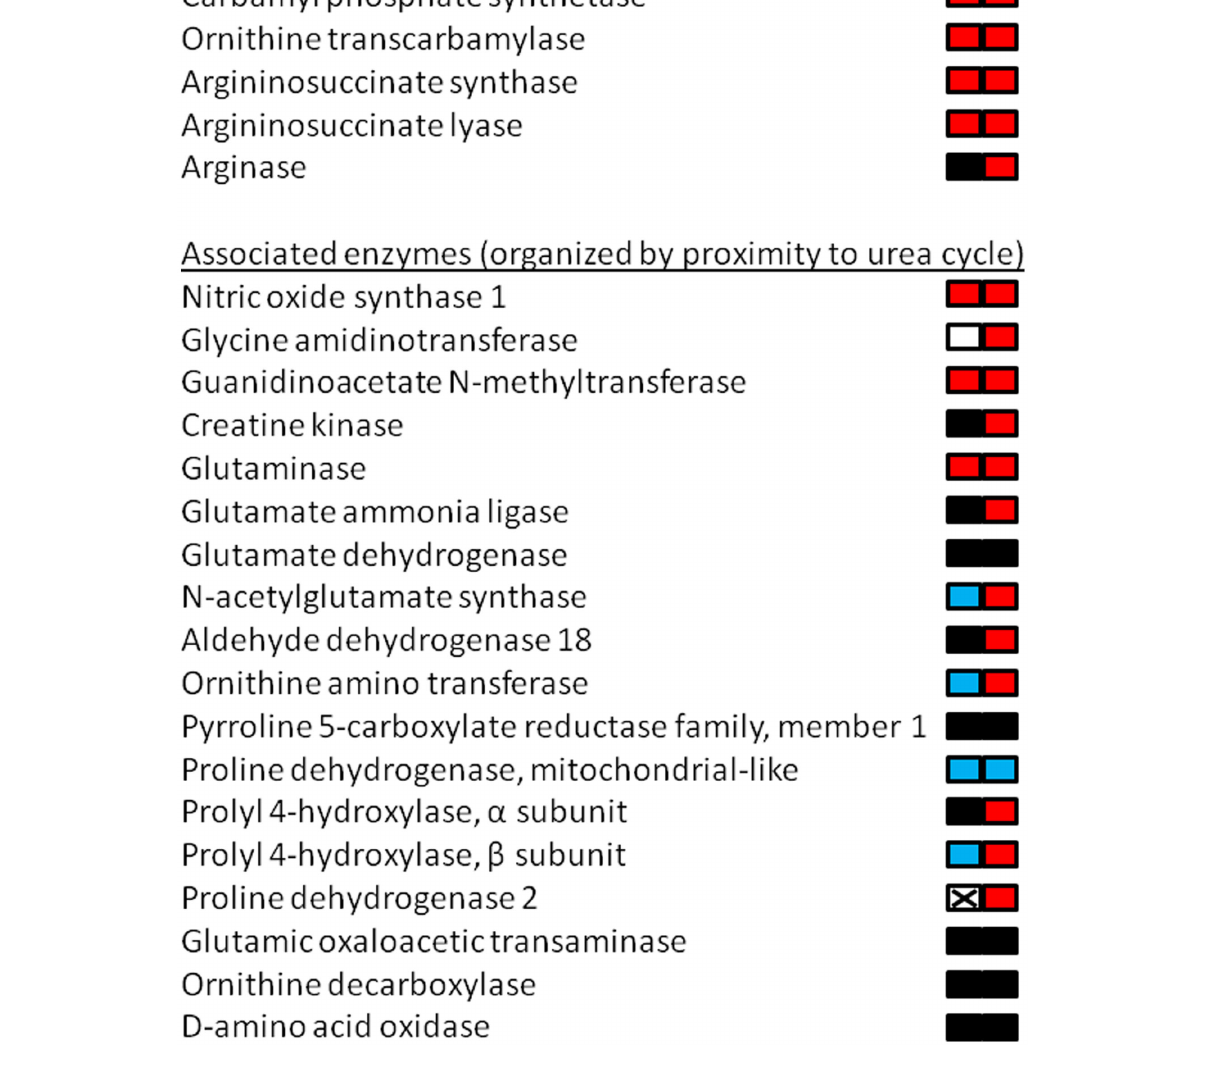
FIGURE 1 | Cartoon depiction of RNA-seq results from the liver of premetamorphic Xenopus laevis and Rana catesbeiana tadpoles focusing upon arginine and proline metabolism including the urea cycle. Tadpoles were exposed to 10nM 3,5,3 (cid:2) -triiodothyronine (a thyroid hormone) or NaOH vehicle control for 48h.The animals were treated and maintained in accordance with the guidelines of the Canadian Council on Animal Care.The liver transcriptomes were subjected to RNA-seq using 75 base HiSeq of paired end tagged (PET) libraries.The derived sequence information was assembled using the X. tropicalis genome as a scaffold and the contig identities were determined by a Blastx search against the X. tropicalis genome.The number of read counts ( ∼ 400 million) was normalized between samples and the relative count frequencies of the indicated pathway components were compared based upon the X. tropicalis arginine and proline metabolism KEGG pathway (xtr00330; www.genome.jp/kegg).The results are depicted as a bipartite rectangle